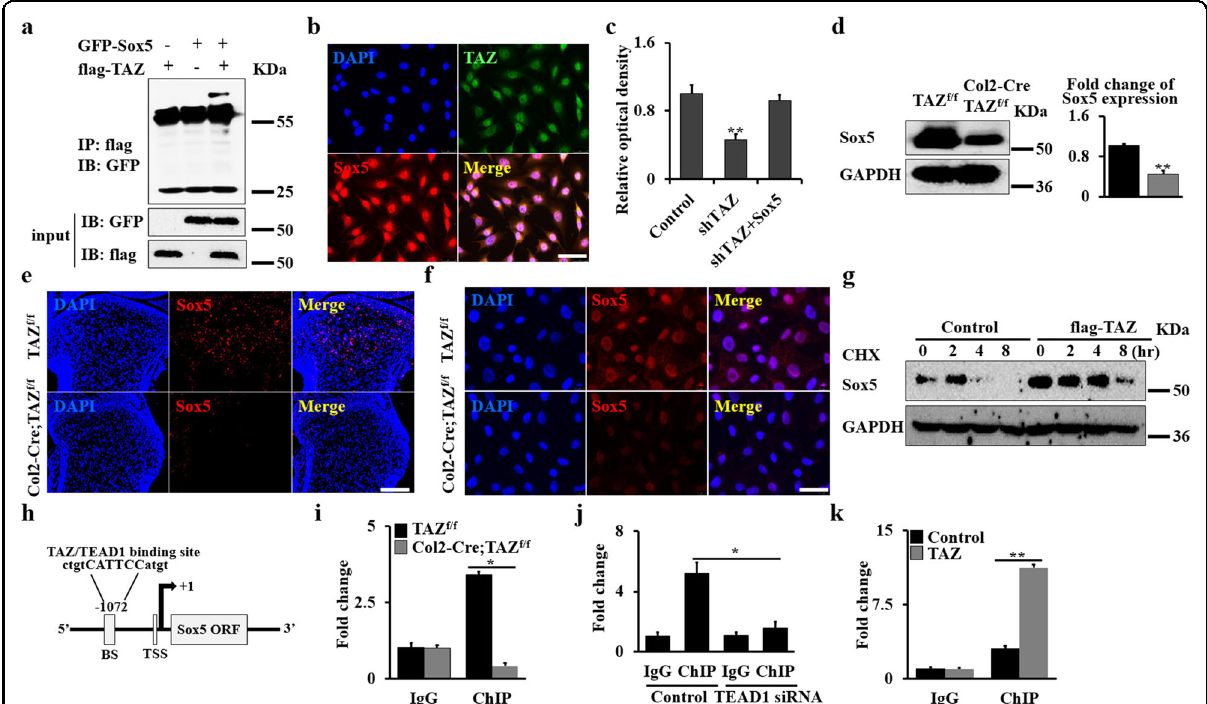
Fig. 5 TAZ partners with TEAD1 to regulate Sox5 expression in chondrocytes. a Co-IP assay. 293 T cells were transfected with GFP-Sox5 or fl ag- TAZ, respectively. Cells were lysed after 48 h, and cell lysates were incubated with fl ag beads. The precipitated complexes were analyzed by western blot. b Immuno fl uorescent staining of TAZ and Sox5 in chondrocytes. Scale bars, 25 μ m. c Cell proliferation rate of chondrocytes as shown by WST-1 assay after 48 h. d Chondrocyte lysates from Col2-Cre;TAZ f/f mice and controls were immunoblotted with antibodies against Sox5 and GAPDH, respectively. The corresponding quantitative analysis of Sox5 expression was performed at right. e , f Representative images of immuno fl uorescence staining for Sox5 in tibia sections or chondrocytes from Col2-Cre;TAZ f/f mice and controls. Scale bars, 75 μ m ( e ) and 10 μ m ( f ). g Chondrocytes were transfected with fl ag-TAZ or empty vector. After 24 h, the cells were treated with 50 μ g/mL cycloheximide (CHX) for different periods of time as indicated. The levels of Sox5 in cell lysates were compared by immunoblotting. h Schematic diagram of TAZ/TEAD1-binding domains in the Sox5 promoter (BS, binding site; TSS, transcription start site). i ChIP assay. Co-occupation of TAZ/TEAD1 in the Sox5 promoter after loss of TAZ. j ChIP assay. Co-occupation of TAZ/TEAD1 in the Sox5 promoter after silence of TEAD1. k ChIP assay. Co-occupation of TAZ/TEAD1 in the Sox5 promoter after overexpression of TAZ. The experiment was independently repeated for three times. Error bars were the means ± SEM of triplicates from a representative experiment. * P < 0.05, ** P <